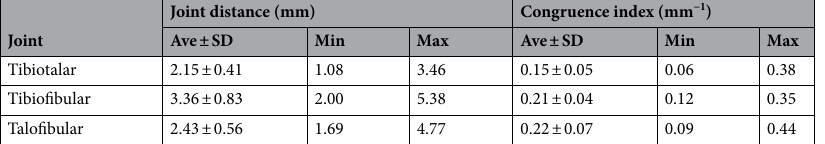
Table 2. Joint distance space and congruence index reported as an average ± standard deviation (SD), with minimum (Min) and maximum (Max) values for the tibiotalar, tibiofibular, and talofibular articular